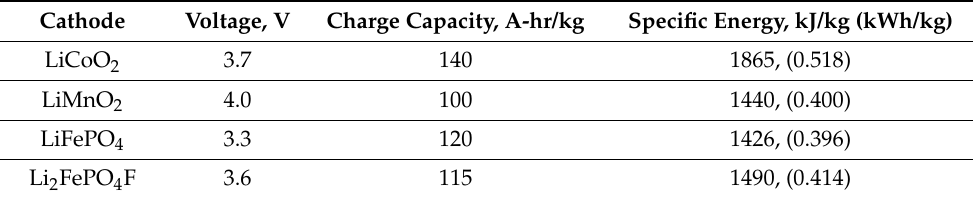
Table 4. Voltage, charge capacity and specific energy (in kJ/kg and kWh/kg) for several types of Li-ion